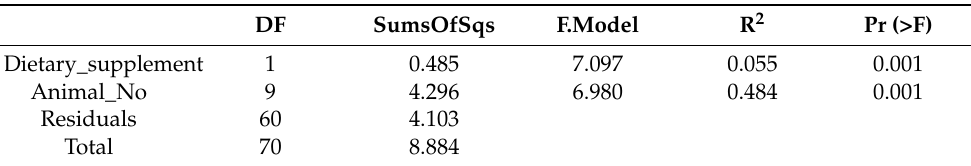
Table 1. Permutational multivariate analysis of variance (PERMANOVA) results based on Bray— Curtis